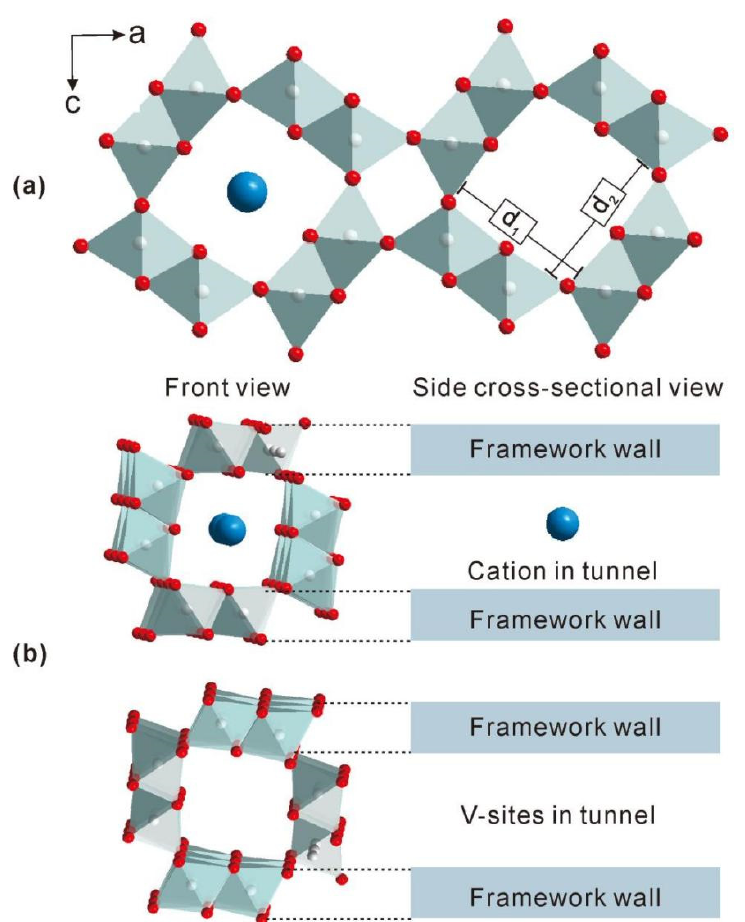
Figure 9. Schematic drawing of the crystal structure of natural cryptomelane. ( a ) The crystal structure is viewed down the b axis of the monoclinic unit cell. Red, white, and blue balls represent O, Mn, and K, respectively. ( b ) Perspective view of a single tunnel of natural cryptomelane (front view and side cross-sectional view) showing the cation or V sites inside the tunnel.